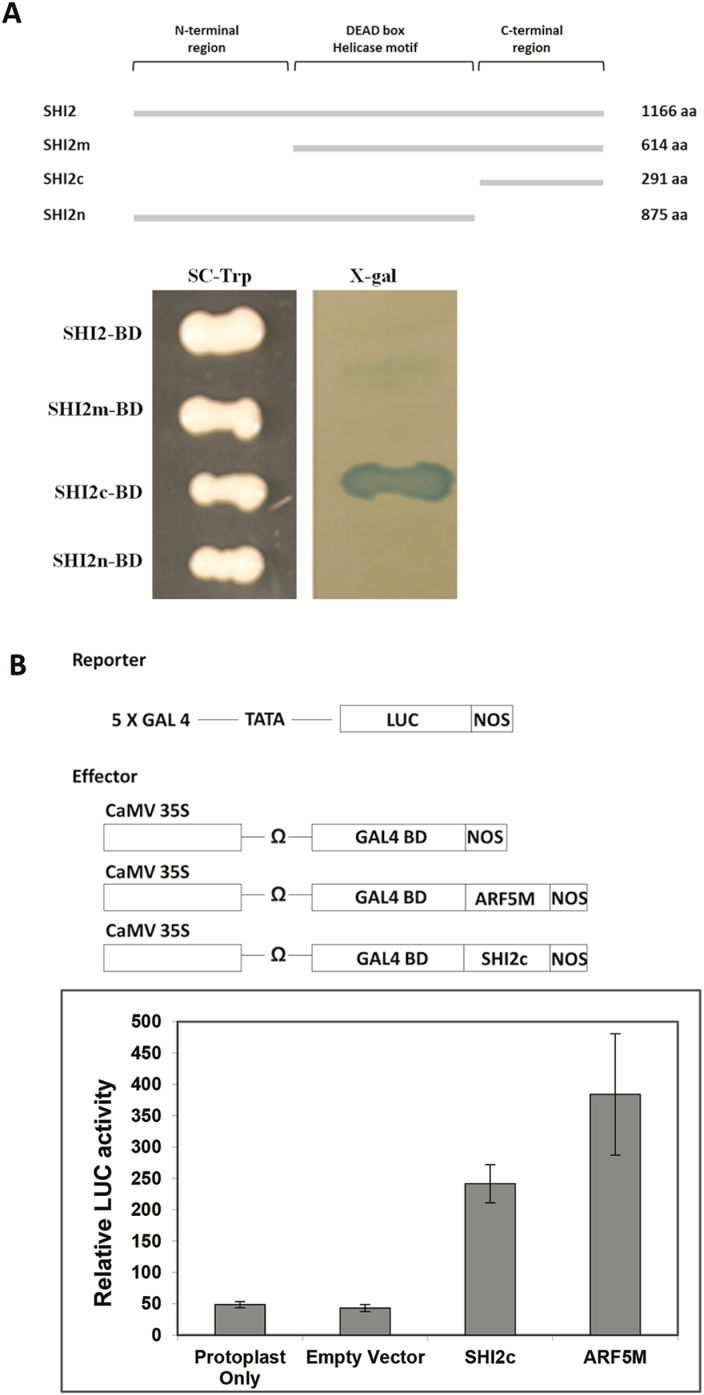
Transcriptional activation by the C-terminus of SHI2. (A) Activation of the reporter gene β-Gal by SHI2c in yeast. Different forms of SHI2 were fused with the DNA-binding domain (BD) in the bait construct, and self-activation assay was used to determine the transcription activation activity of SHI2, SHI2m, SHI2c, and SHI2n. (B) SHI2c shows much higher LUC activity than the empty vector control in Arabidopsis protoplasts. ARF5M (Auxin Response Factor 5 Middle region) was used as a positive control. Data are means ±SD (n=3). (This figure is available in color at JXB online.)